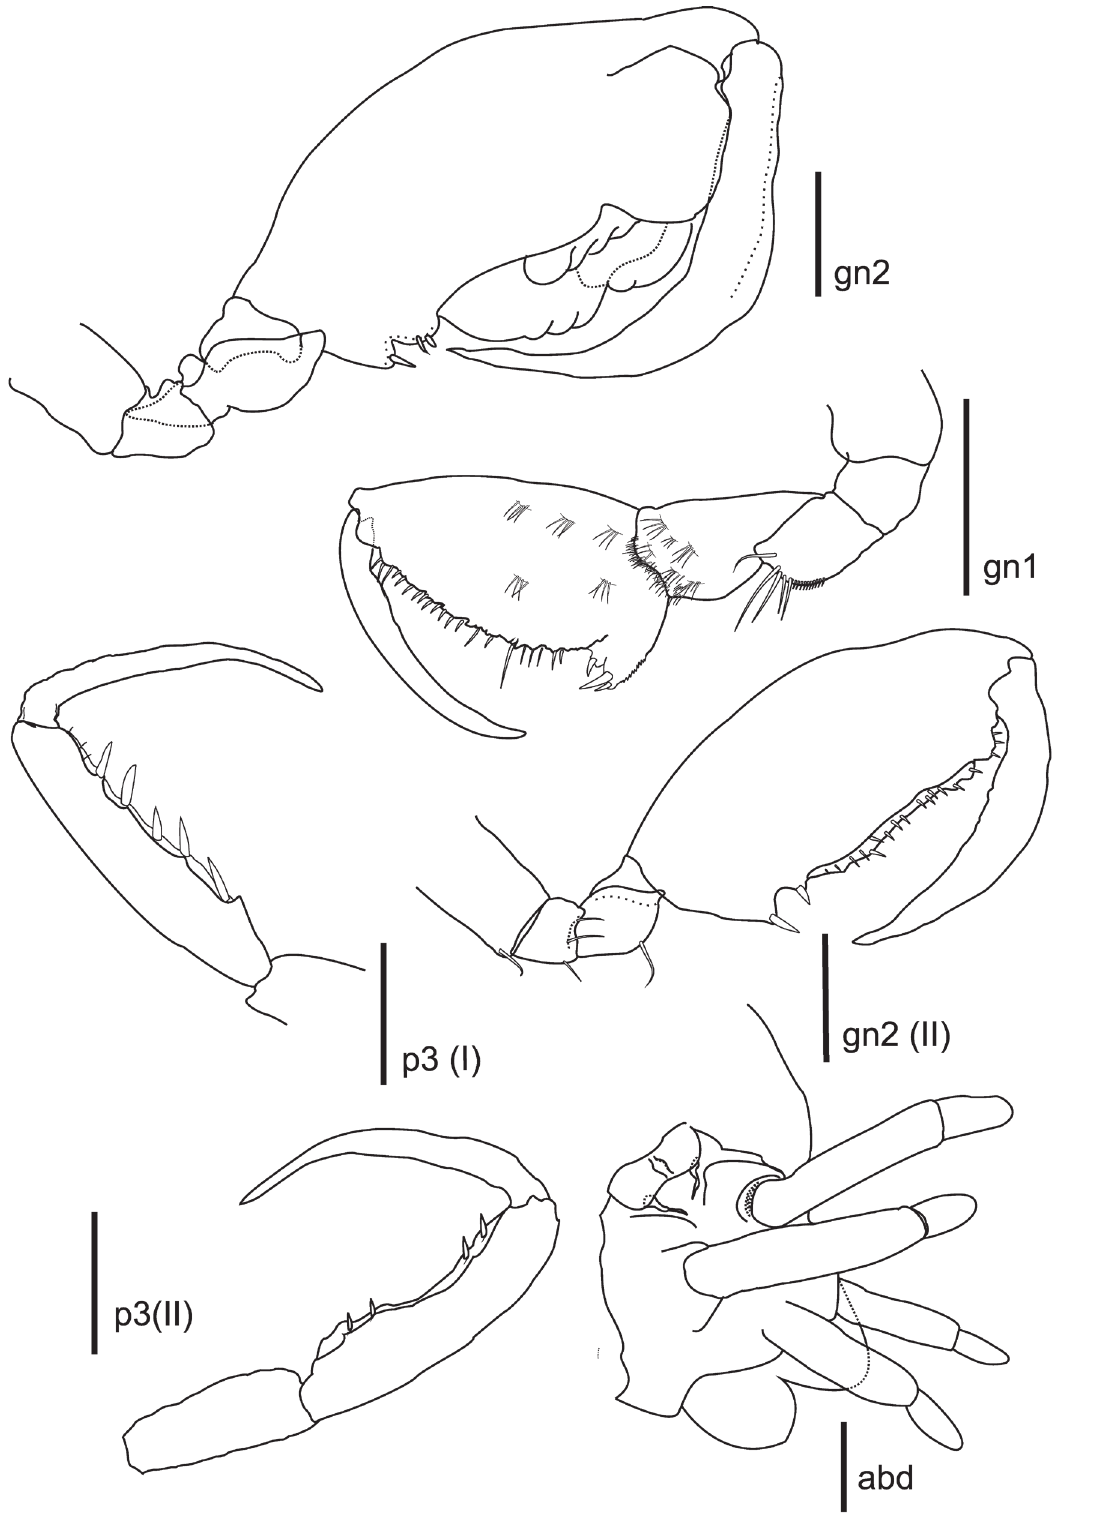
Fig. 4. Phtisica marina Slabber, 1769, 12.2 mm, Angra dos Reis, RJ (CDZRJ 1014). Adult male morphotype I, 11.7 mm, Campos Basin (MNRJ23483). Scale bars: gn2 = 0.3 mm; gn1, p3, p4, abd = 0.1